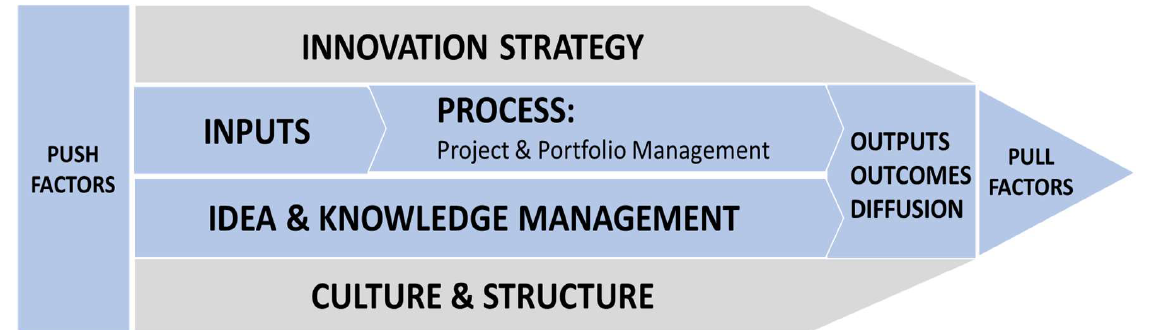
Figure 1. The framework of process innovation implementation. (Source: Authors’ elaboration).